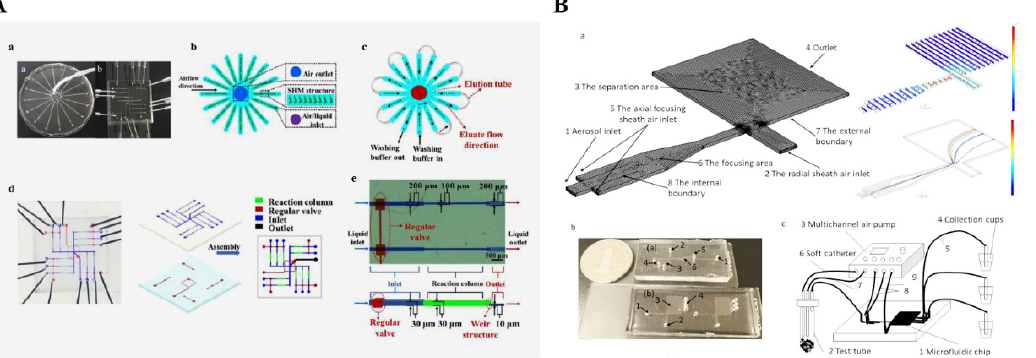
Figure 5. ( A ) On-chip fluorescence immunoassay for detection of the bioaerosols containing fungal spores. (a) airborne spore enrichment chip and detection chip. (b) Schematic illustration of the en- richment chip when sampling air. (c) Schematic illustration of the enrichment chip when eluting spores. (d) Image of the detection chip and schematic illustration of the detection chip. (e) Image and illustration of the detection units on the chip. Reproduced with permission from ref. [106]. Cop- yright 2018 American Chemical Society. ( B ) Microfluidic extraction chip simulation, physical and experimental device. (a) Simulation analysis, (b) the air spore extraction chip physical map, and (c) the air spore extraction experimental platform. Reproduced with permission from ref. [105]. Copy- right 2019 American Institute of Physics.